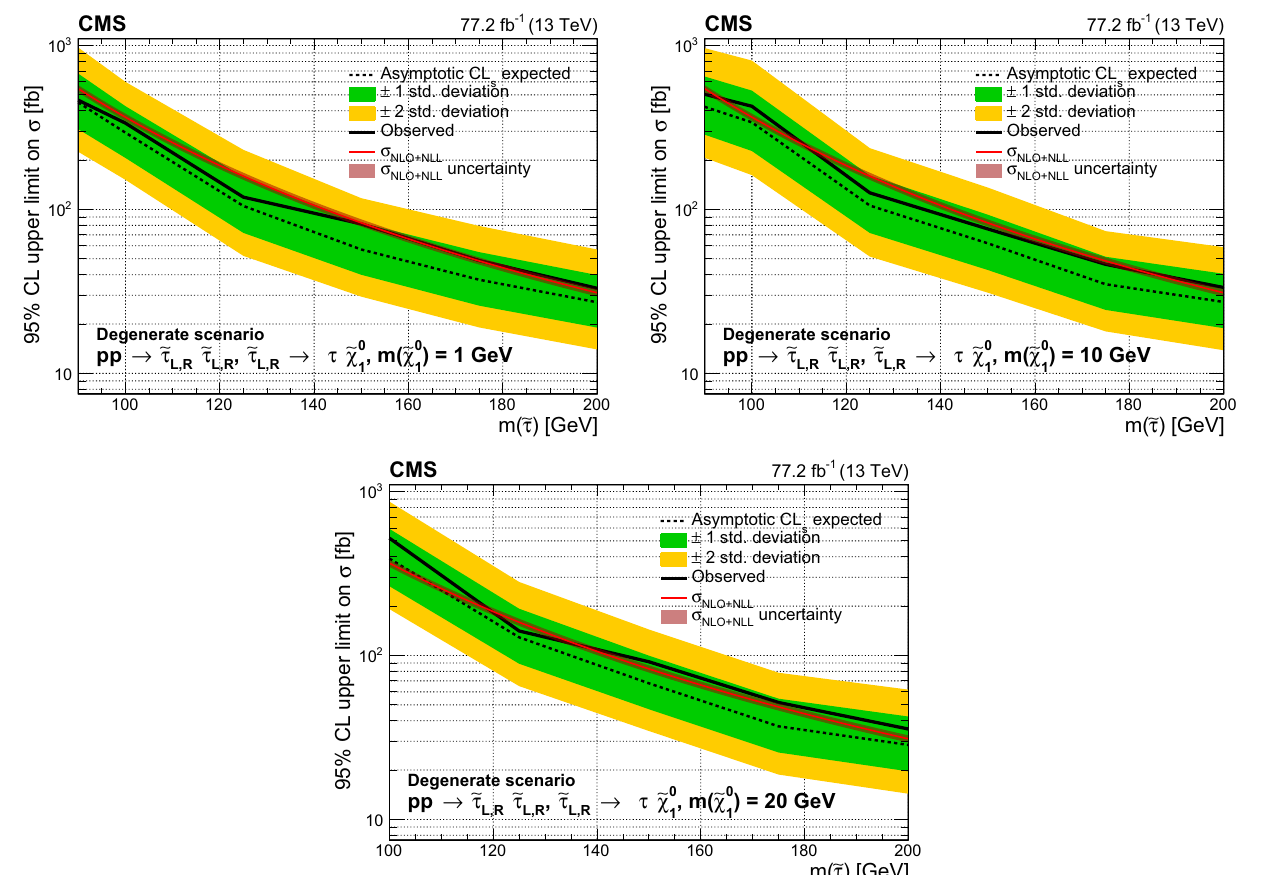
Fig. 9 Upper limit on the cross section ( σ ) of (cid:2) τ pair production and outer (yellow) bands indicate the respective regions containing 68 and 95% of the distribution of limits expected under the background- excluded at 95% CL as a function of the (cid:2) τ mass in the degenerate (cid:2) τ only hypothesis. The solid red line indicates the NLO+NLL prediction models for a (cid:2) χ 0 mass of 1GeV (upper left), 10GeV (upper right) and 1 forthesignalproductioncrosssectioncalculatedwith Resummino [37], 20GeV (lower). The results shown are for the statistical combination of τ while the red shaded band represents the uncertainty in the the 2016 and 2017 data in the τ and (cid:2) τ analyses. The inner (green) h h h